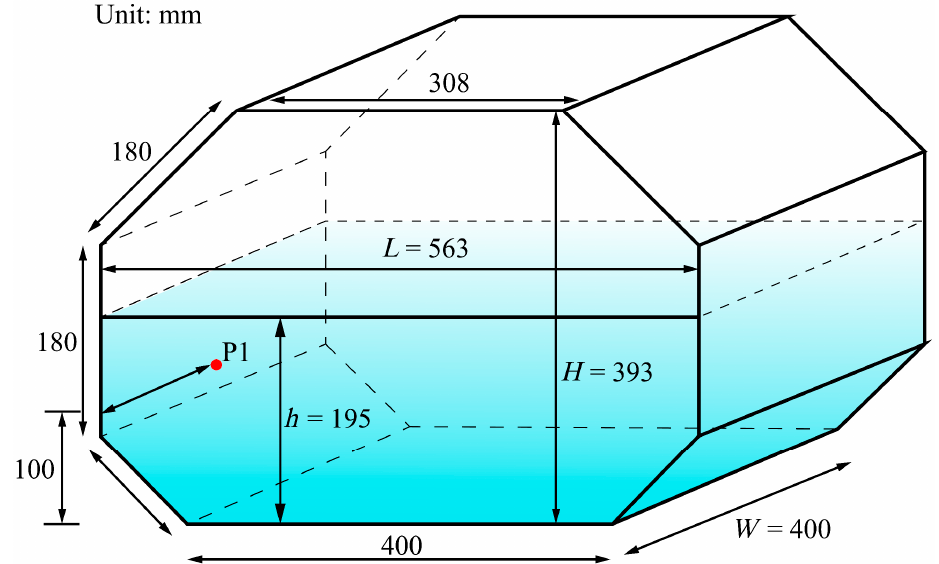
Figure 3. Diagram of the membrane-type tank and corresponding arrangements.